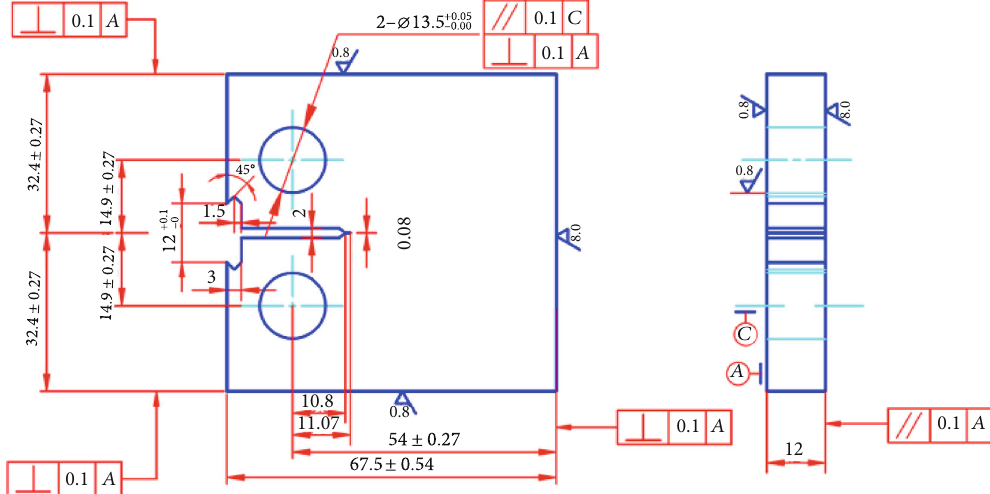
Figure 6: Designing size of the crack growth test specimen.